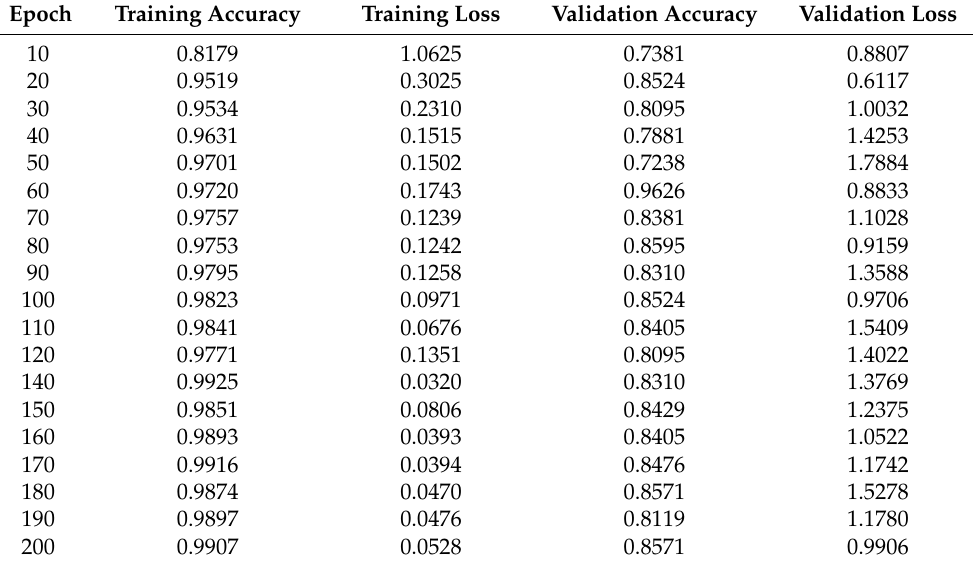
Table 6. Accuracy calculation for detection of monkeypox disease detection.